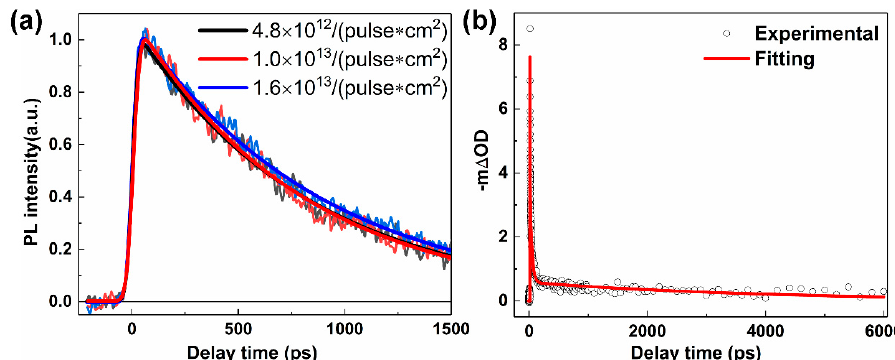
Figure 5. ( a ) TRPL kinetics of Y6 film at indicated excitation fluence after photoexcitation at 775 nm. ( b ) TA kinetics of Y6 film at a probe wavelength of 870 nm after photoexcitation at 700 nm; the excitation was 2 × 10 15 photons cm − 2 . The solid lines after fitting curves using exponential decay functions; the fitting parameters can be found in supporting information (Tables S6 and